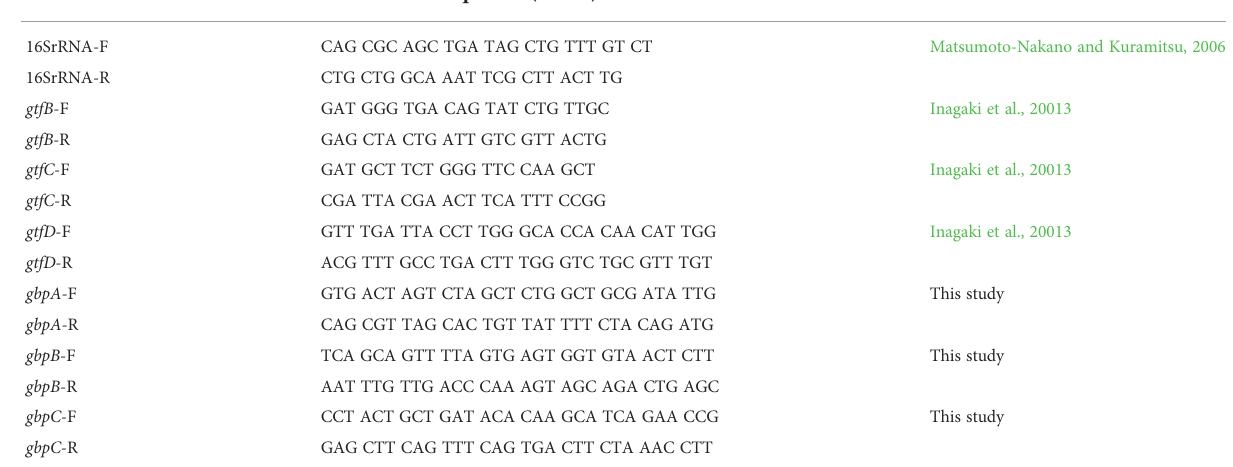
TABLE 2 Primers used for qRT-PCR in this